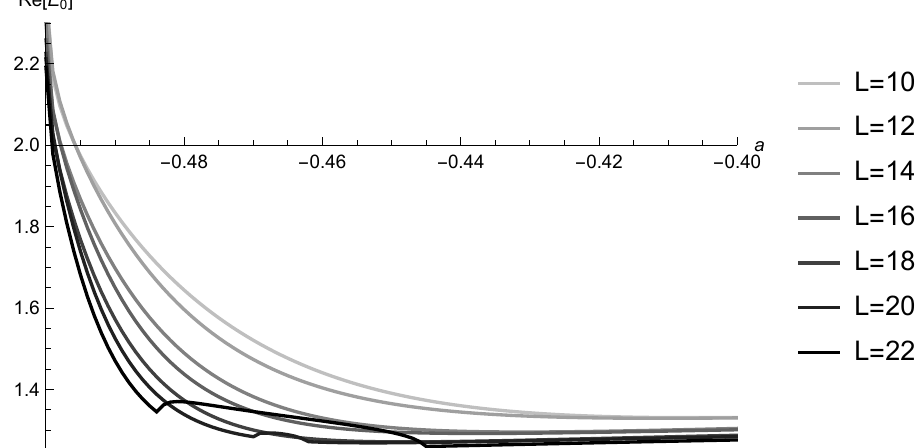
Figure 5 . Plots of the real part of the gauge invariant observable E 0 (2.17) for the “double brane” solution Φ D such as a & − 1 / 2 at the truncation level L = 10 , 12 , · · · , 22 . The horizontal a axis denotes the value of the parameter a at Re E 0 = 2 . The vertical axis stands at a = − 1 / 2 .